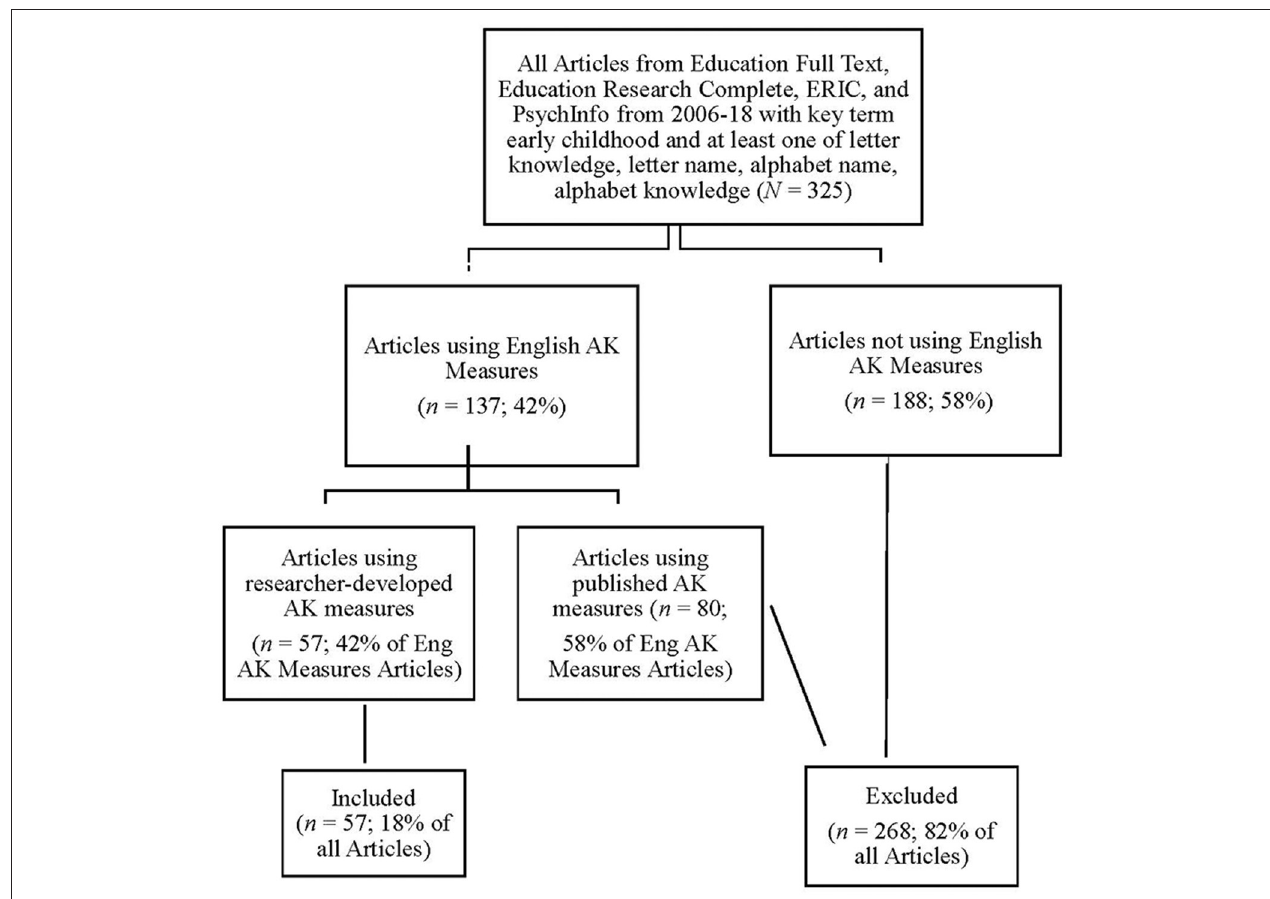
FIGURE 1 | Flow of articles through each stage of inclusionary